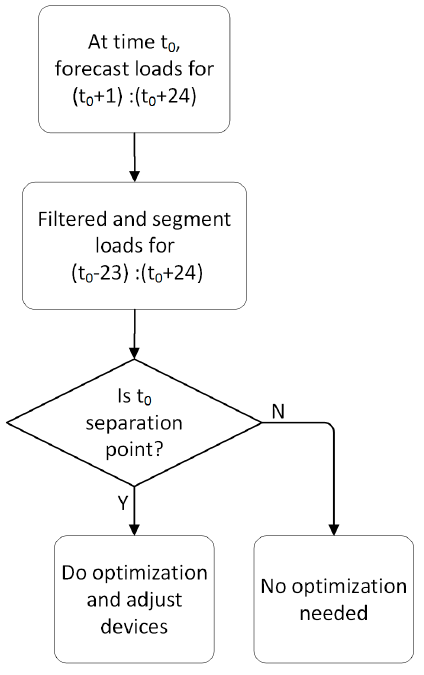
Figure 1. Flow chart of online reactive power optimization.